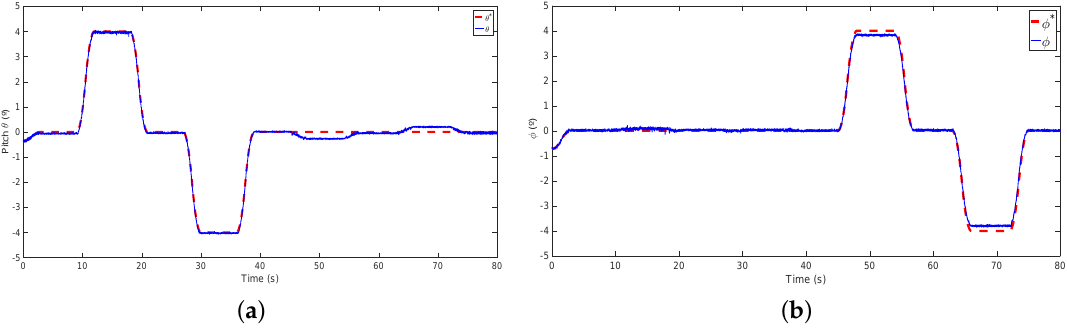
F using the proposed control system. { }